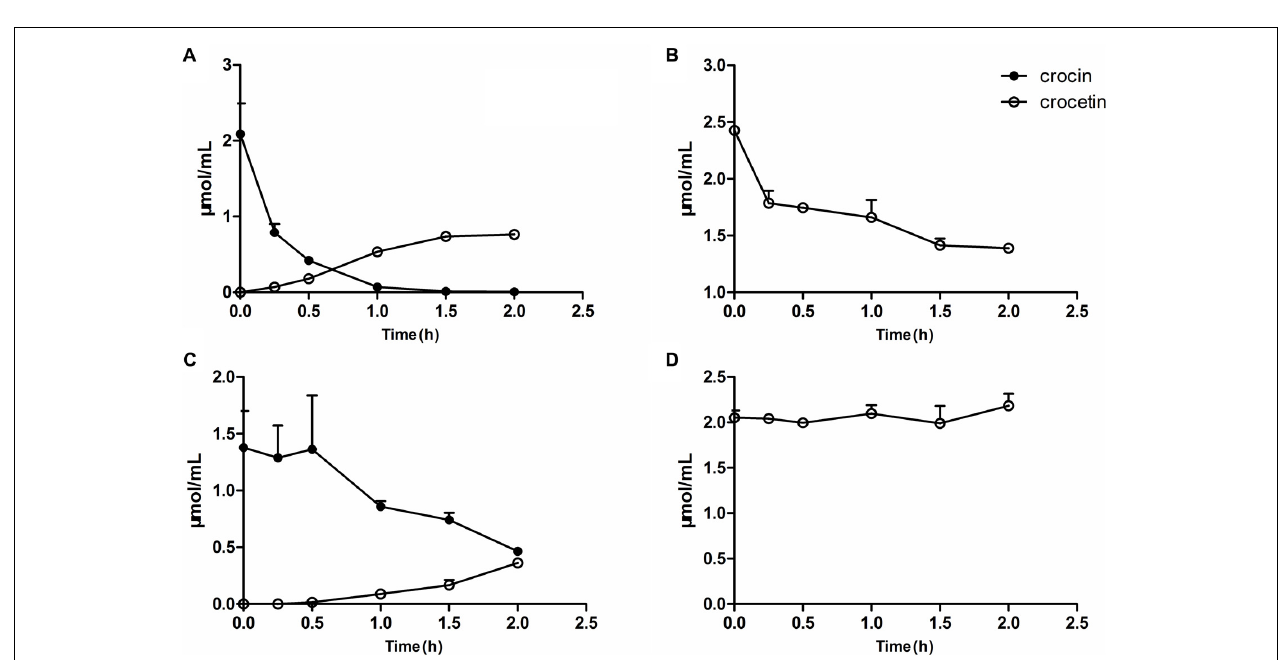
FIGURE 6 | Metabolism of crocin and crocetin by gut flora in vitro . The metabolism of crocin (A) and crocetin (B) by the gut flora from normal rats. The metabolism of crocin (C) and crocetin (D) by the gut flora from pGF rats. Data are represented as the mean ± SD ( n =